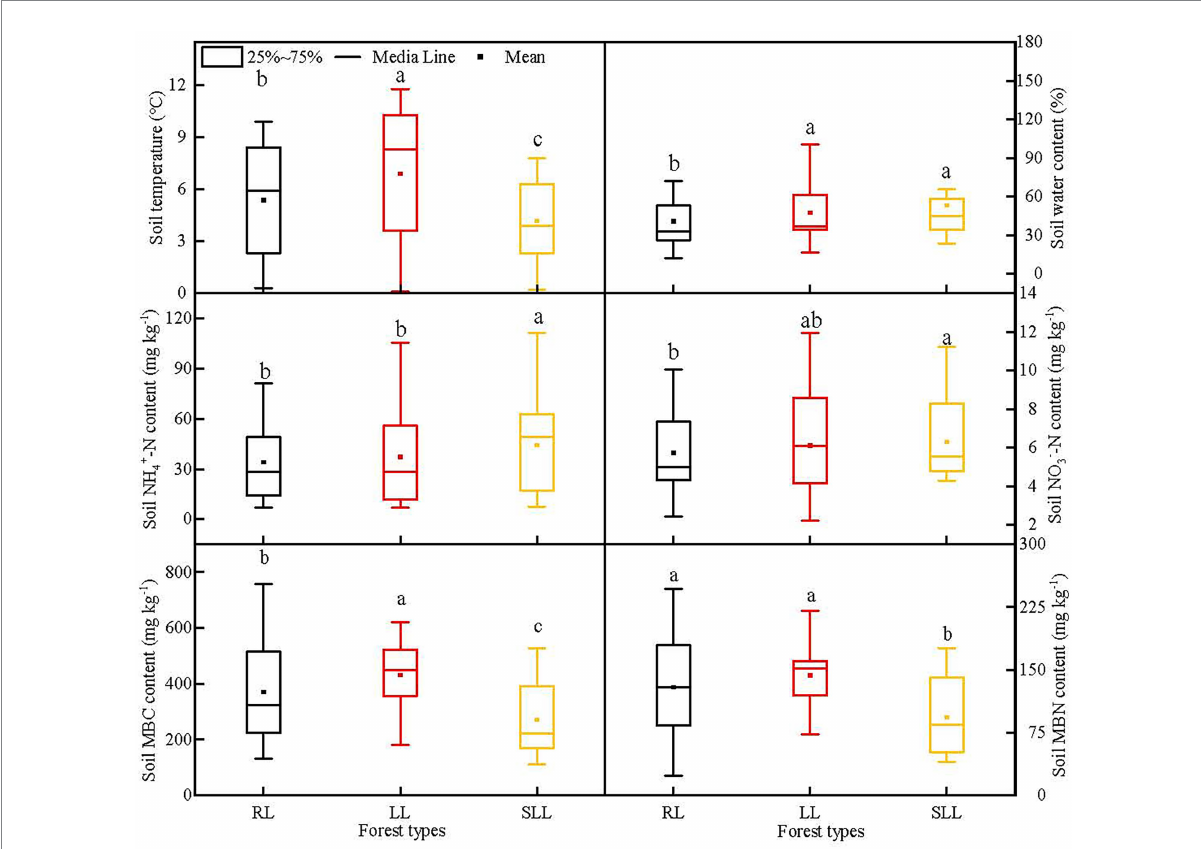
FIGURE 1 Soil environmental factors, soil inorganic nitrogen, and microbial biomass contents among three types of larch forest. LL, Ledum palustre-Larix gmelinii forest; RL, Rhododendron dauricum-Larix gmelinii forest; and SLL, Sphagnum-Bryum-Ledum palustre-Larix gmelinii forest. Different lowercase letters indicate statistically significant differences among different types of larch